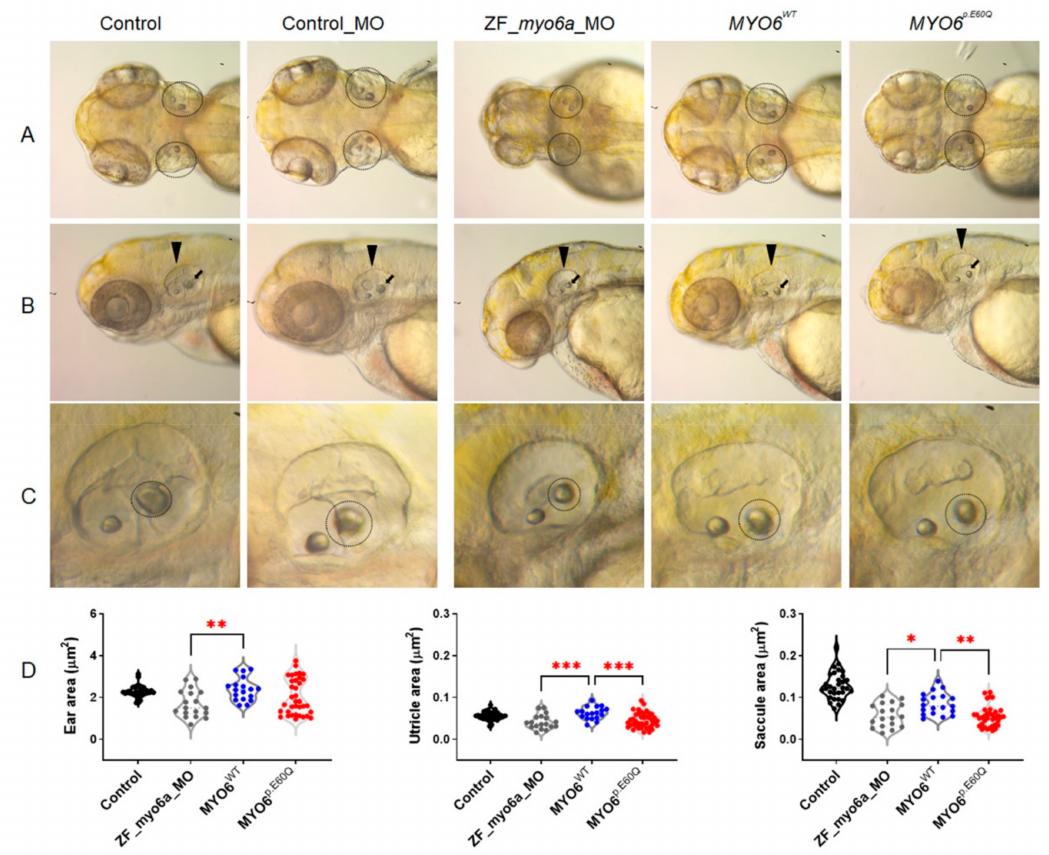
Figure 4. Detection of ear morphological defects in zebrafish models. ( A ) Dorsal view of zebrafish at 72 hpf. ( B ) Lateral view of the posterior otolith at 72 hpf zebrafish (black arrow). ( C ) Closeup view of zebrafish ear morphology (black dashed circle). ( D ) The perimeter length of zebrafish ear, utricle, and saccule area in µ m 2 . The total number of experiments was 3, and the number of embryos analyzed was 31, 18, 19, and 36 for control, ZF_myo6a_MO, MYO6 WT , and MYO6 p.E60Q groups, respectively. One-way ANOVA using GraphPad Prism software (version 8.0) and Tukey’s multiple comparisons test with p -values of * p < 0.05, ** p < 0.01, *** p <